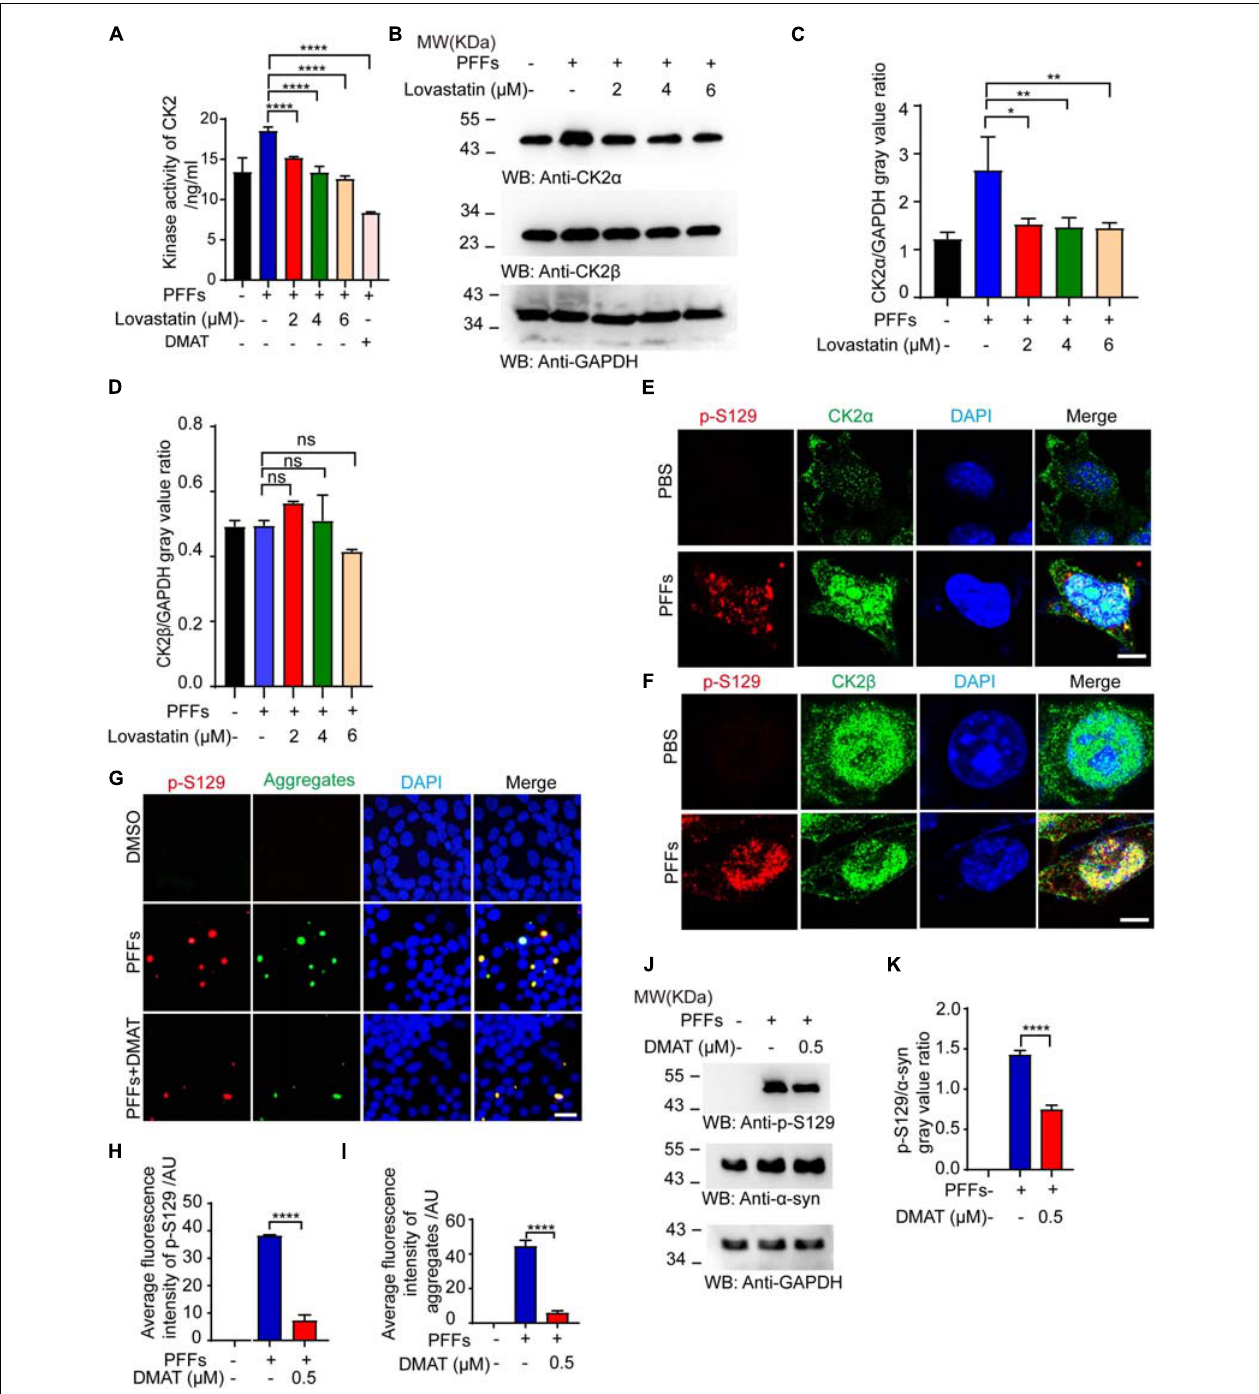
FIGURE 4 | Lovastatin inhibits the activation of CK2. (A) Kinase activation of CK2. (B) Western blot detecting the levels of CK2 α and CK2 β . (C,D) Quantitative analysis of CK2 α and CK2 β levels. (E) Double-immunostaining for p-S129 and CK2 α in the SH-SY5Y treated by α -syn PFFs. Bar = 8 µ m. (F) Double-immunostaining for p-S129 and CK2 β in the SH-SY5Y treated by α -syn PFFs. Bar = 8 µ m. (G) Immunostaining showing CK2 inhibitor DMAT decreased the phosphorylation and inclusion. (H) Quantification of p-S129 α -syn after DMAT treatment. (I) Quantification of aggregates after DMAT treatment. (J) Western blot detecting the level of p-S129 α -syn. (K) Quantification of p-S129 α -syn in Western blot. Results are normalized to total α -syn. All data are means ± SEM, * P < 0.05, ** P < 0.01, *** P < 0.001, and **** P < 0.0001, ns: not statistically significant, one-way ANOVA with Tukey’s multiple comparisons test. All experiments were performed in triplicate for at least three independent